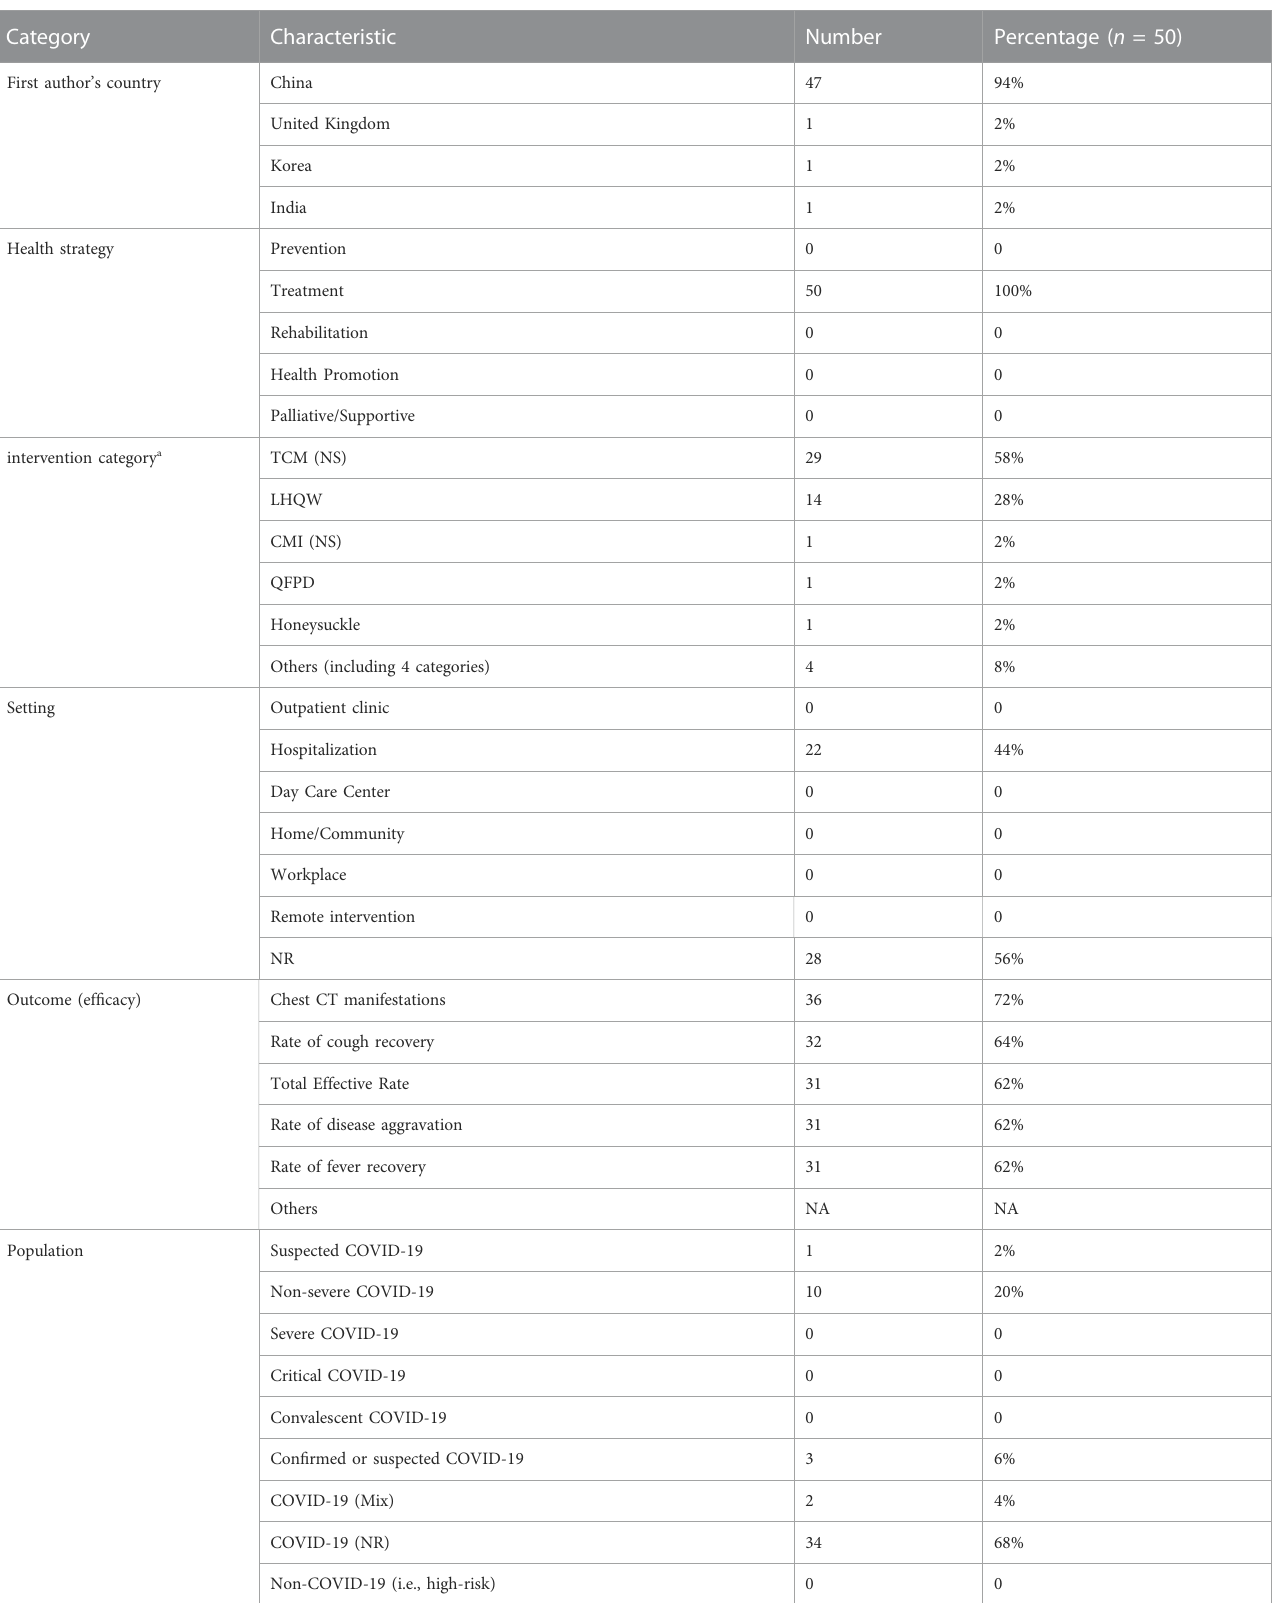
TABLE 2 Essential characteristics of the included